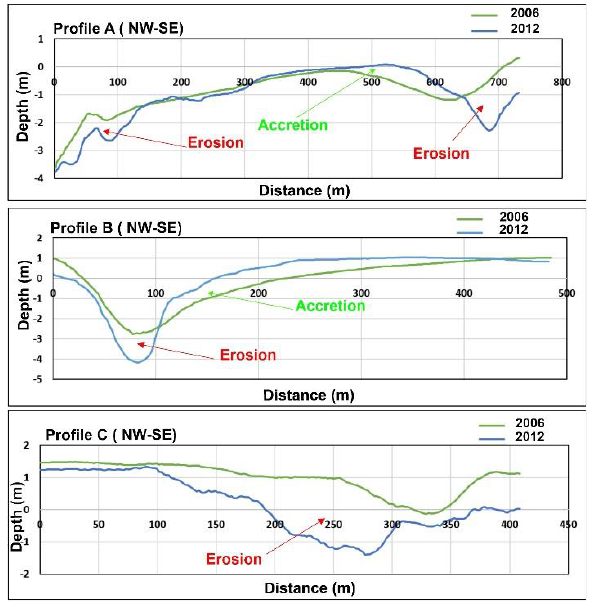
Figure 10. Profiles A, B and C. Green – 2006 and Blue-2012. Profile locations are shown in figure 1